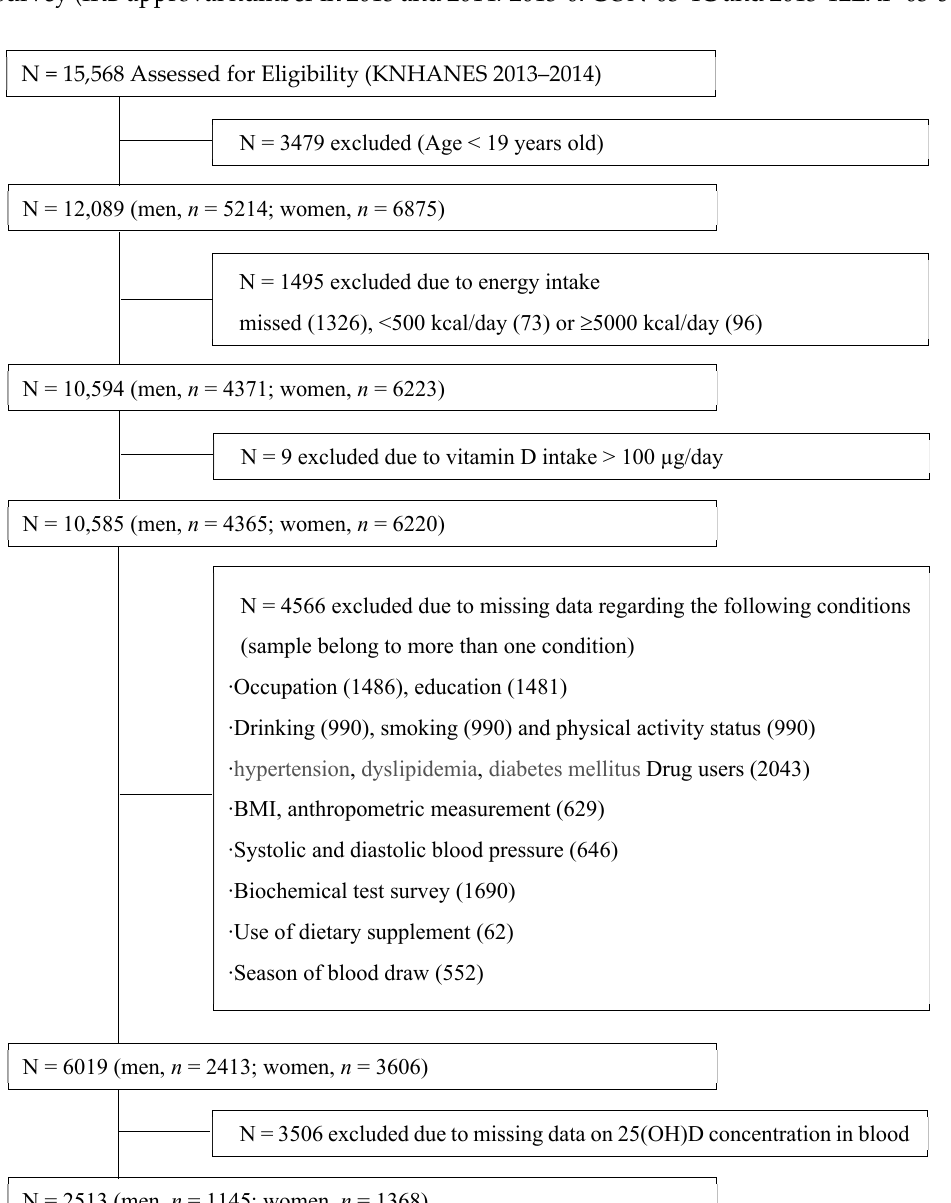
Figure 1. Flowchart of participant inclusion and exclusion in the Korea National Health and Nutrition Examination Survey 2013–2014 (BMI; body mass index; 25(OH)D, 25 ‐ hydroxyvitamin D).